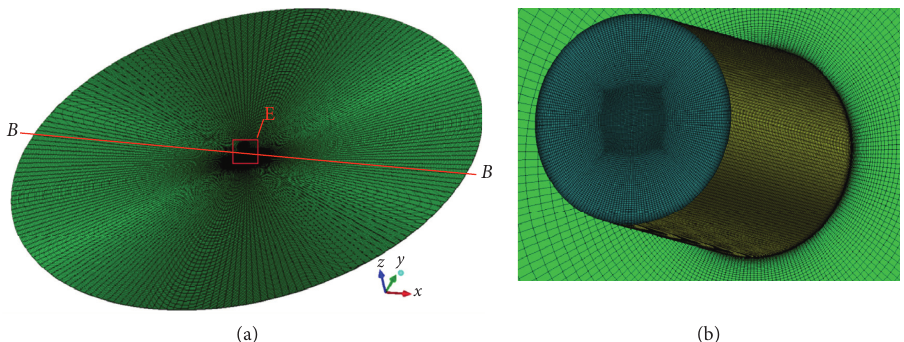
Figure 3: Schematic diagram of the grid division of the outlet of the orifice. (a) Grid division of area A of the dotted box; (b) local magnification of grids at E.